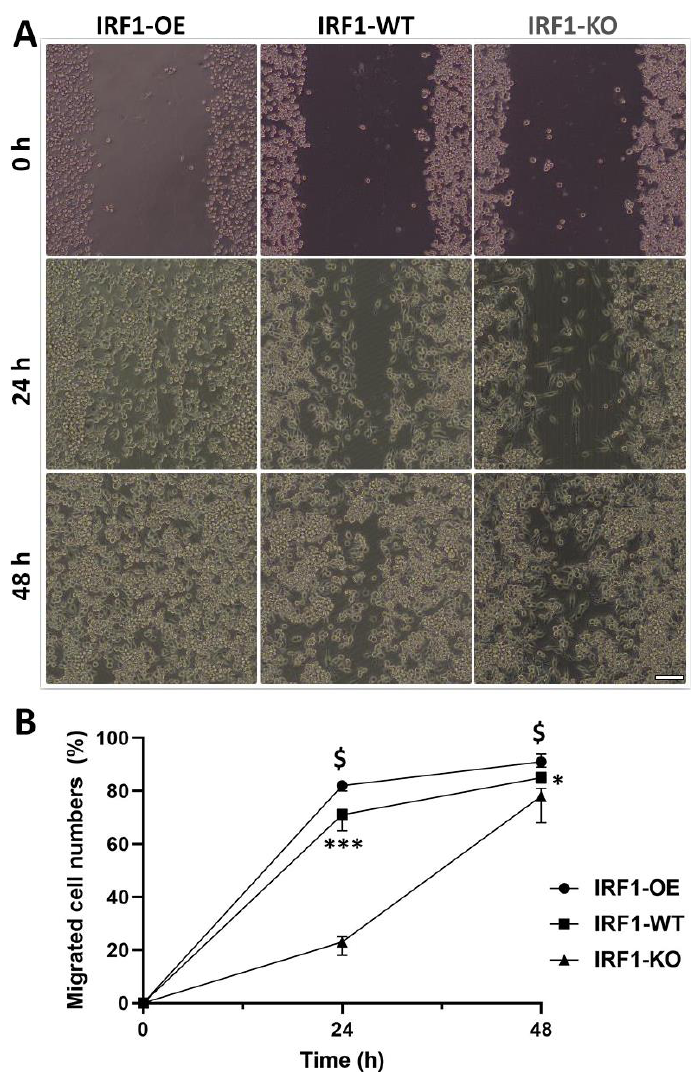
Figure 3. Microglial migration competency by cell scratch assay. The BV2 cells with the genotypes of IRF1-WT, IRF1-KO (BV2 ΔIRF1 ), and IRF1-OE (overexpression) were cultivated to confluency. The cells were physically removed by scratching, and then the cell images were taken by differential interference contrast (DIC) microscopy at 24 and 48 h ( A ). 40× magnification. The cells in the scratched areas were quantified ( B ). N = 3; * p < 0.05; *** p < 0.001 (IRF1-WT vs. IRF1-KO). $ p < 0.05 (IRF1-OE vs. IRF1-WT).